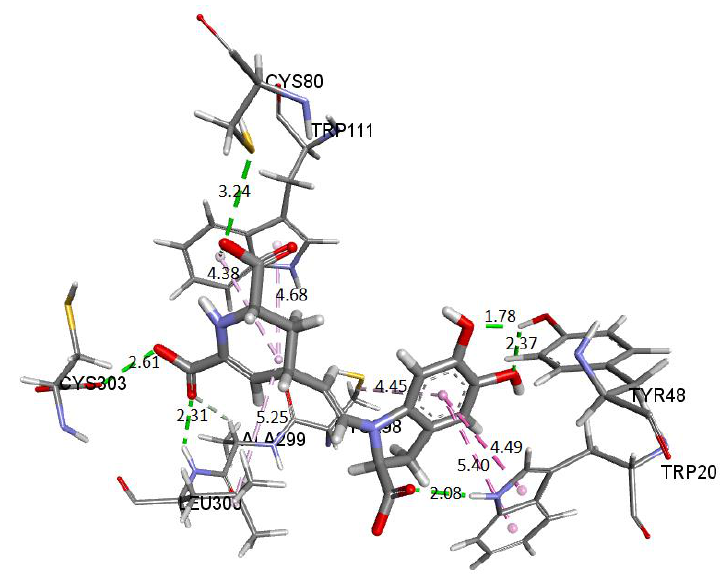
Figure 28. The DM study obtained the interactions of π and hydrogen bonds of the Ligand 1 compound with AR.